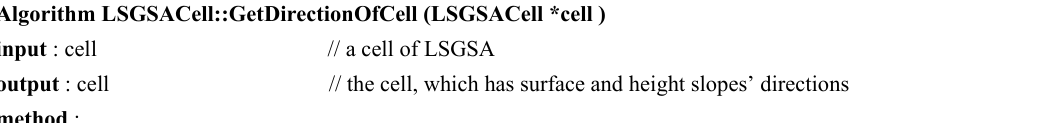
Algorithm 2. Get surface and height slope’s directions of a cell of LSGSA. Algorithm LSGSACell::GetDirectionOfCell (LSGSACell *cell